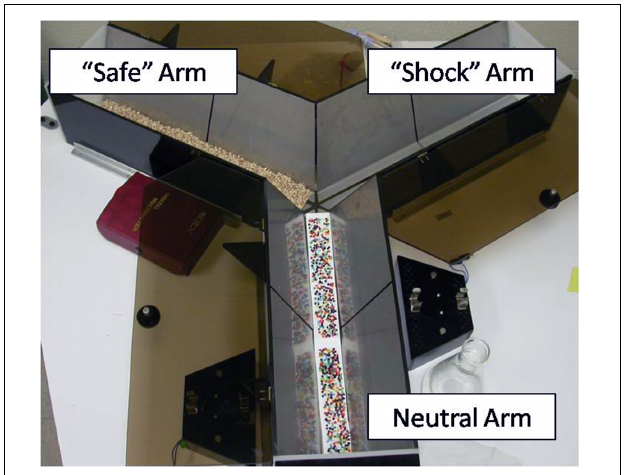
FIGURE 2 | Picture of the Y-maze used for the Generalization Test in Experiment 2. The neutral arm served as the main stem of the maze. Flooring for the neutral arm consisted of a beaded cardboard insert; a novel environment and texture. The left and right arms of the maze were counterbalanced so there was an equally likely chance of the right arm resembling the “shock” or “safe” arm. The “safe” arm consisted of fresh corncob bedding normally used to line the bottom of the animal’s home cage. The “shock” arm had metal floors similar to those in the water-motivated inhibitory avoidance task in which animals were previously